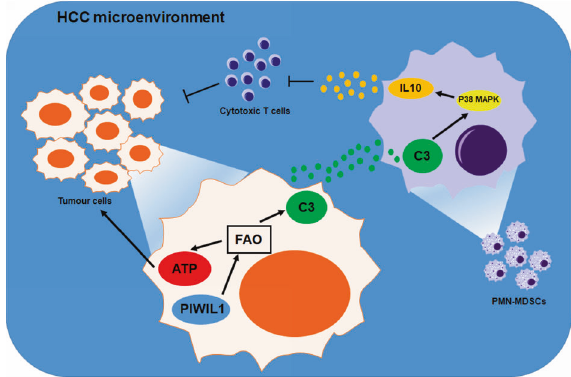
Fig. 7 Schematic regulation mechanism of PIWIL1 in